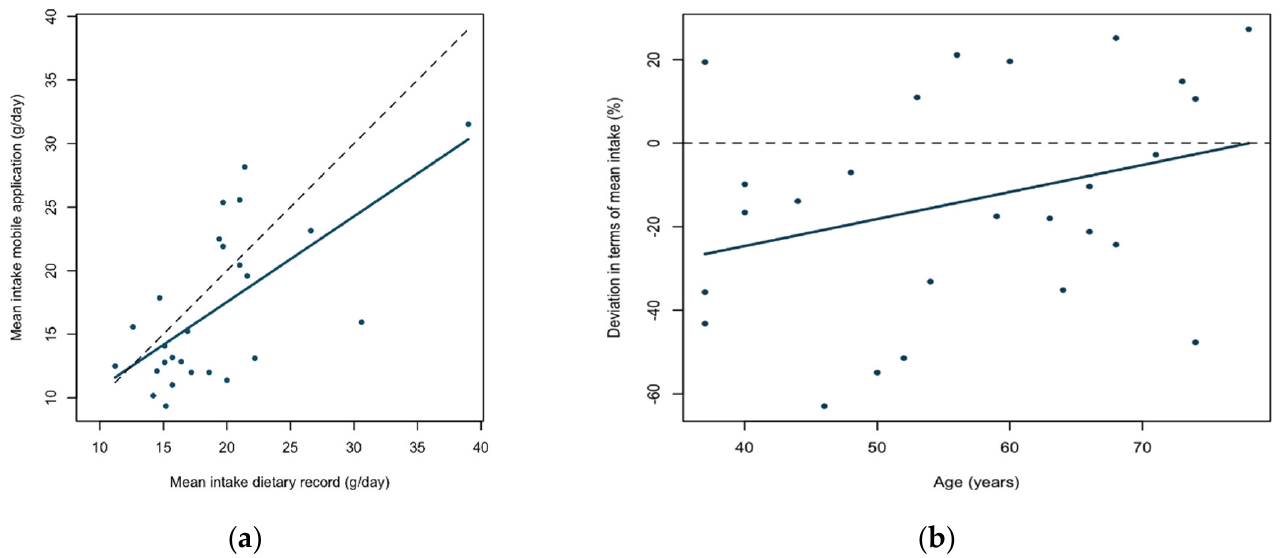
Figure 4. ( a ) Pearson correlation plot of correlation between mean fiber intake (g) measured by the mobile phone application and the dietary record ( n = 26). The dashed line presents a unity line (x = y). ( b ) Regression analysis including the deviation in terms of percentage of mean fiber intake as measured by the mobile phone application and the dietary record and age ( n = 26). The dashed line at zero is included for reference.